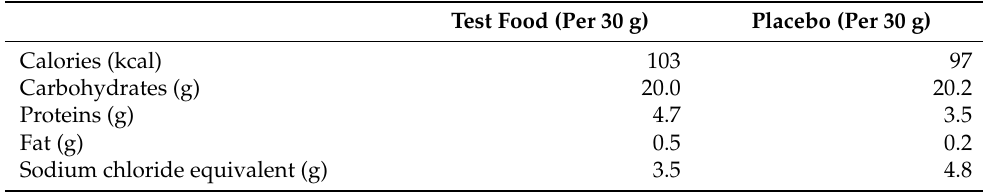
Table 1. Comparison of the analysis values of nutrient composition of sample food per